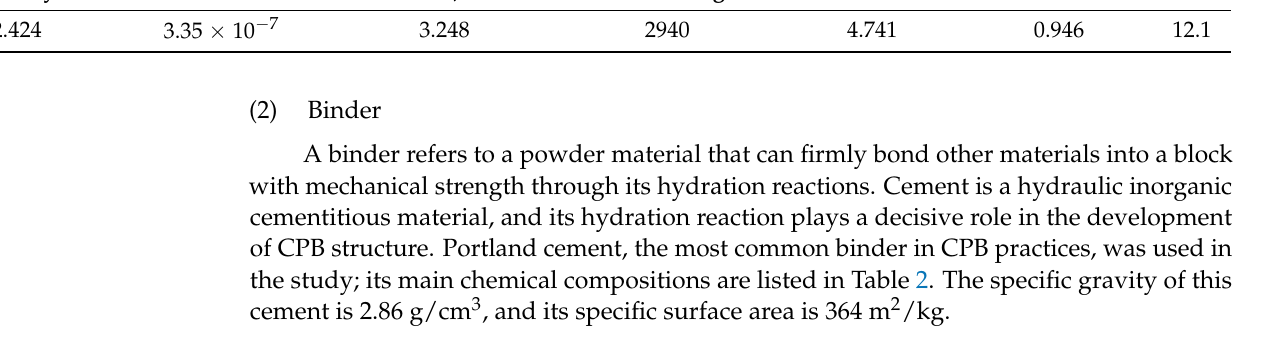
Table 2. Main chemical compositions of cement and